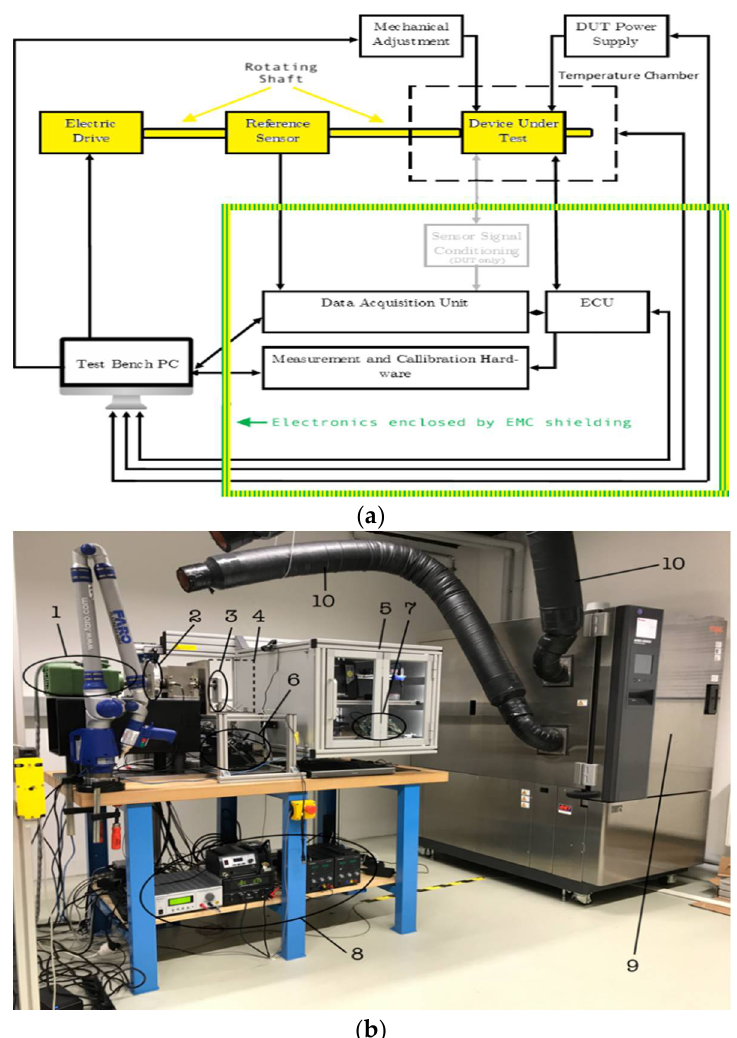
Figure 13. Sensor test bench ( a ) sensor test bench system overview; ( b ) sensor test bench and relevant components: 1, electric drive; 2, reference sensor; 3, device under test (DUT); 4, specific temperature